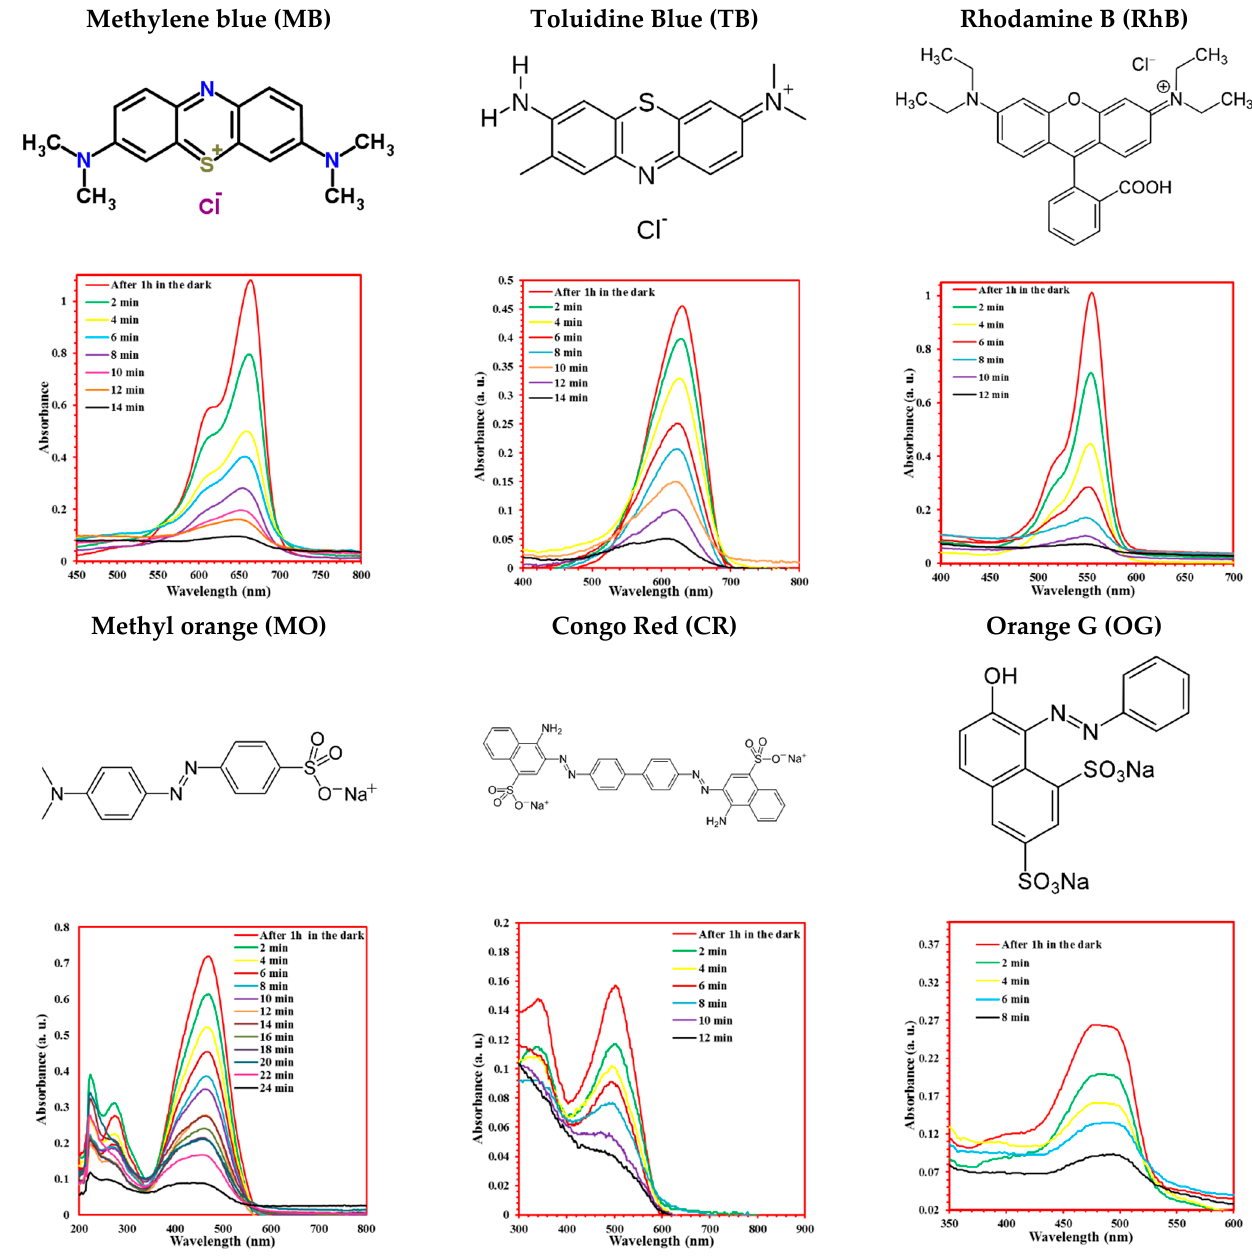
Figure 10. UV-Vis absorption with time irradiation of a solution containing 100 mg of BiP and 5 ppm of pollutants (MB, TB, RhB, MO, CR,